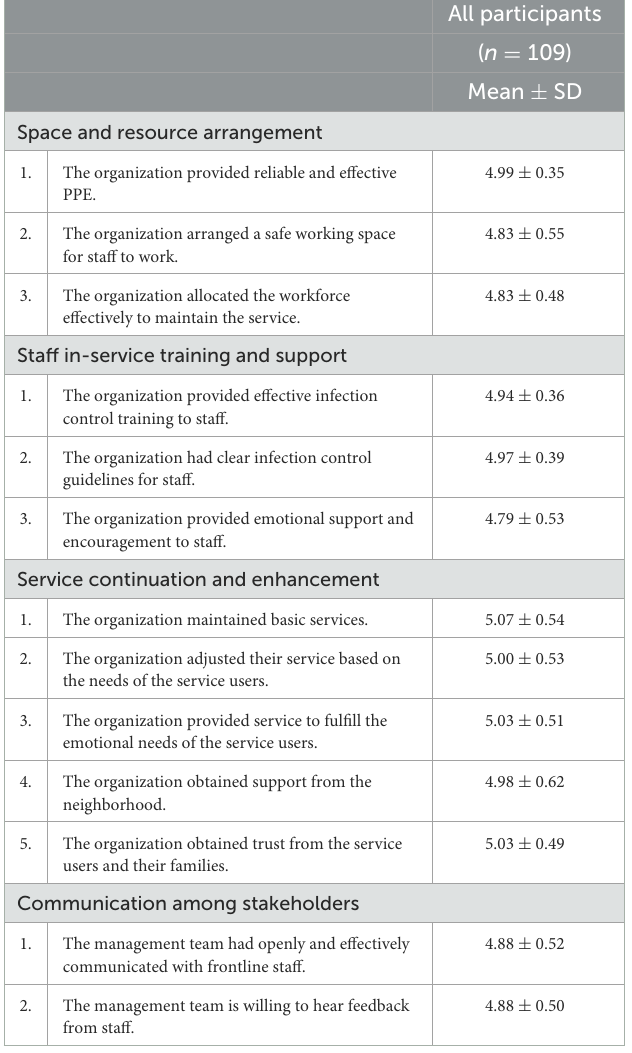
TABLE 4 Mean scores on the extent of agreement on risk management measures amidst the COVID-19 pandemic ( n = 109).